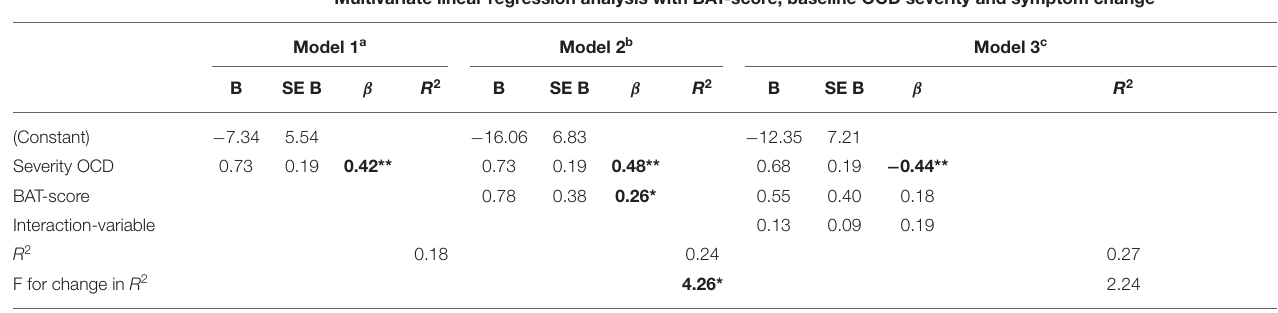
TABLE 3 | Summary of the multivariate linear regression analysis for the relation between the BAT-score and symptom change. Multivariate linear regression analysis with BAT-score, baseline OCD severity and symptom